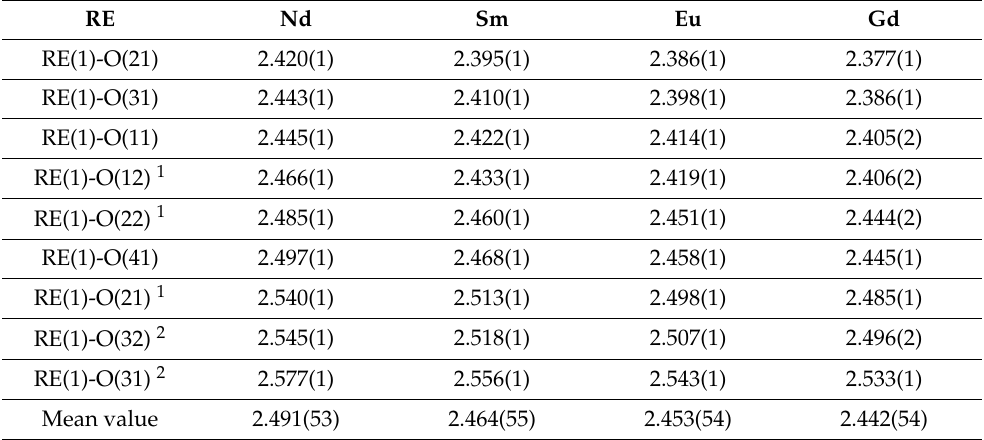
Table 2. Rare earth oxygen distances [Å] in the ninefold, mono-capped square-antiprismatic coordi- nation spheres of the rare earth atoms in the RE(OAc) 3 · 2AcOH structure